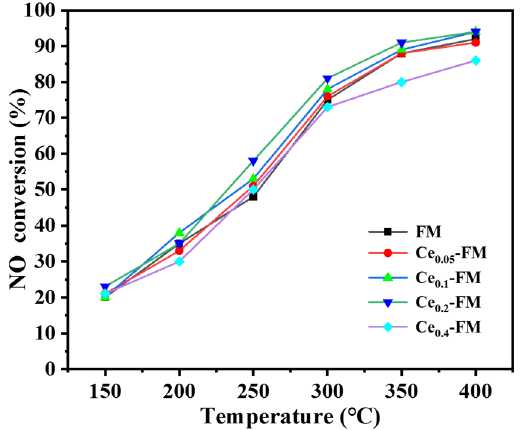
Figure 1. Effect of Ce doping ratio on the denitration performance of the catalysts.